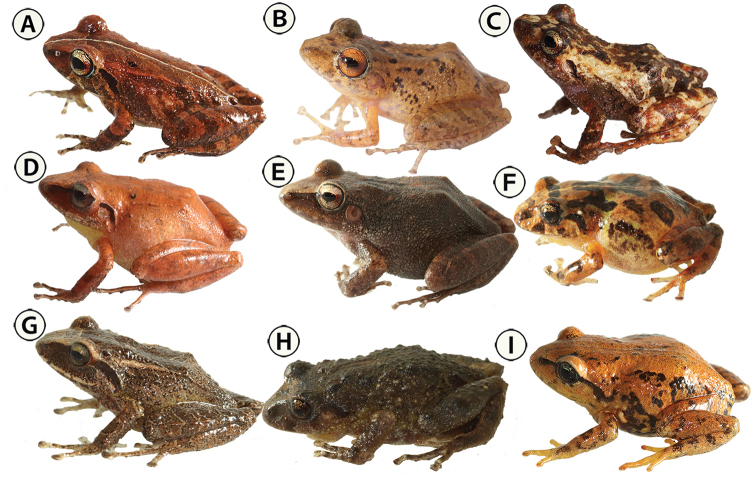
Live specimens (lateral view) of Pristimantis currently known from the eastern Andean Cordillera associated with the Orinoco basin in Colombia. APristimantis
carranguerorum, Medina Municipality, Cundinamarca Department, IAvH-Am-14954 (adult female, SVL = 22.6 mm) BPristimantis
medemi, Medina Municipality, Cundinamarca Department, IAvH-Am-15025 (adult male, SVL = 32.5 mm) CPristimantis
frater, Medina Municipality, Cundinamarca Department, IAvH-Am-14923 (adult female, SVL = 27.8 mm) DPristimantis
savagei, Medina Municipality, Cundinamarca Department, IAvH-Am-14933 (adult male, SVL = 23.2 mm) EPristimantis
vilarsi, La Macarena Municipality, Meta Department, IAvH-Am-15095(Adult female, SVL = 44.8 mm) FPristimantis
bogotensis, Cabrera Municipality, Cundinamarca Department, IAvH-Am-15345 (adult male, SVL = 21.9 mm) GPristimantis
anolirex, Santa Barbara Municipality, Santander Department, IAvH-Am-15654 (juvenile female, SVL = 22.3 mm) HPristimantis
lynchi, Tasco Municipality, Boyacá Department, IAvH-Am-15871 (adult male, SVL = 22.1 mm) IPristimantis
nicefori, Santa Barbara Municipality, Santander Department, IAvH-Am-15730 (SVL = 24.5 mm). Photographs by Andrés Acosta-Galvis.